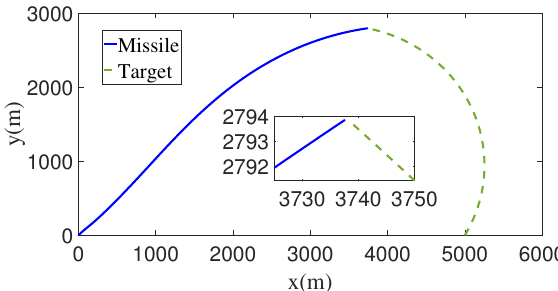
Figure 8. The flight trajectories of the missile and the target with constant maneuver.